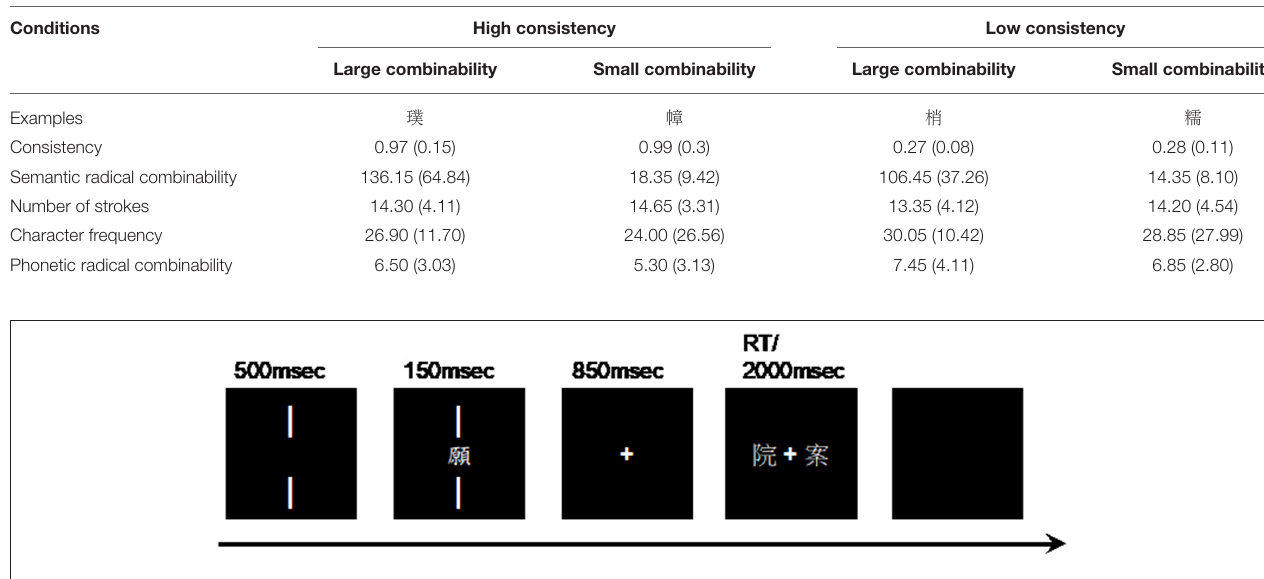
FIGURE 1 | Schematic of the